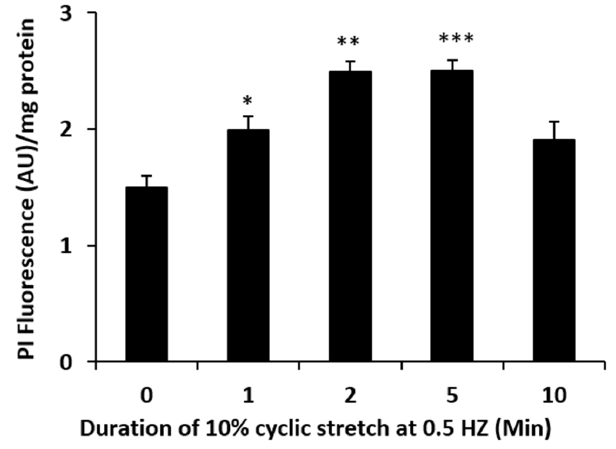
Figure 4. The influence of a stretch stimulus on the uptake of propidium iodide (PI), used here as an indicator of hemichannel opening. The results show PI fluorescence determined in monolayers of cultured NPE cells measured after subjecting the cells to 10% cyclic stretch (0.5 Hz) for 1–10 min in Krebs’ solution containing 25 µM PI. The fluorescence data, presented as arbitrary units (AU), are the mean ± SE of results from six independent experiments. * ( p < 0.05), ** ( p < 0.01) and *** ( p < 0.001) indicate significant differences from control.